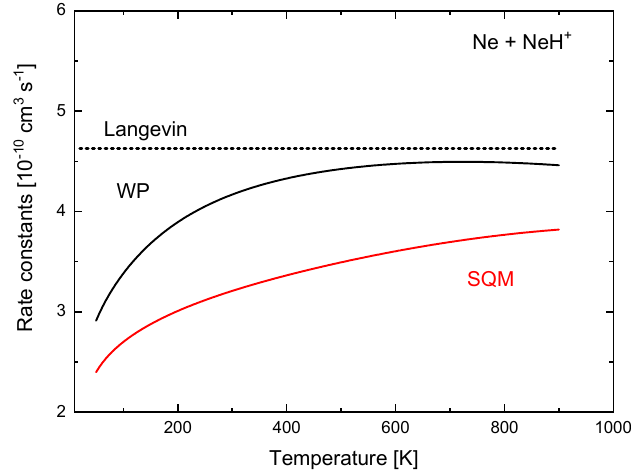
Figure 16. Rate constants (in 10 − 10 cm 3 s − 1 ) for the Ne + NeH + reaction calculated with TDWP (black line) and SQM (red line) approaches of Reference [70]. Langevin prediction is also included (dotted